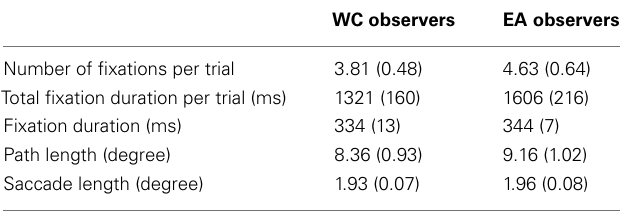
Table 2 | Global eye-tracking measures to the culture of the observer: average number of fixations per trial, average total fixation duration per trial (in ms), average single fixation duration (in ms), scan path length per trial (in degrees on visual angle), and average saccade length (in degrees on visual